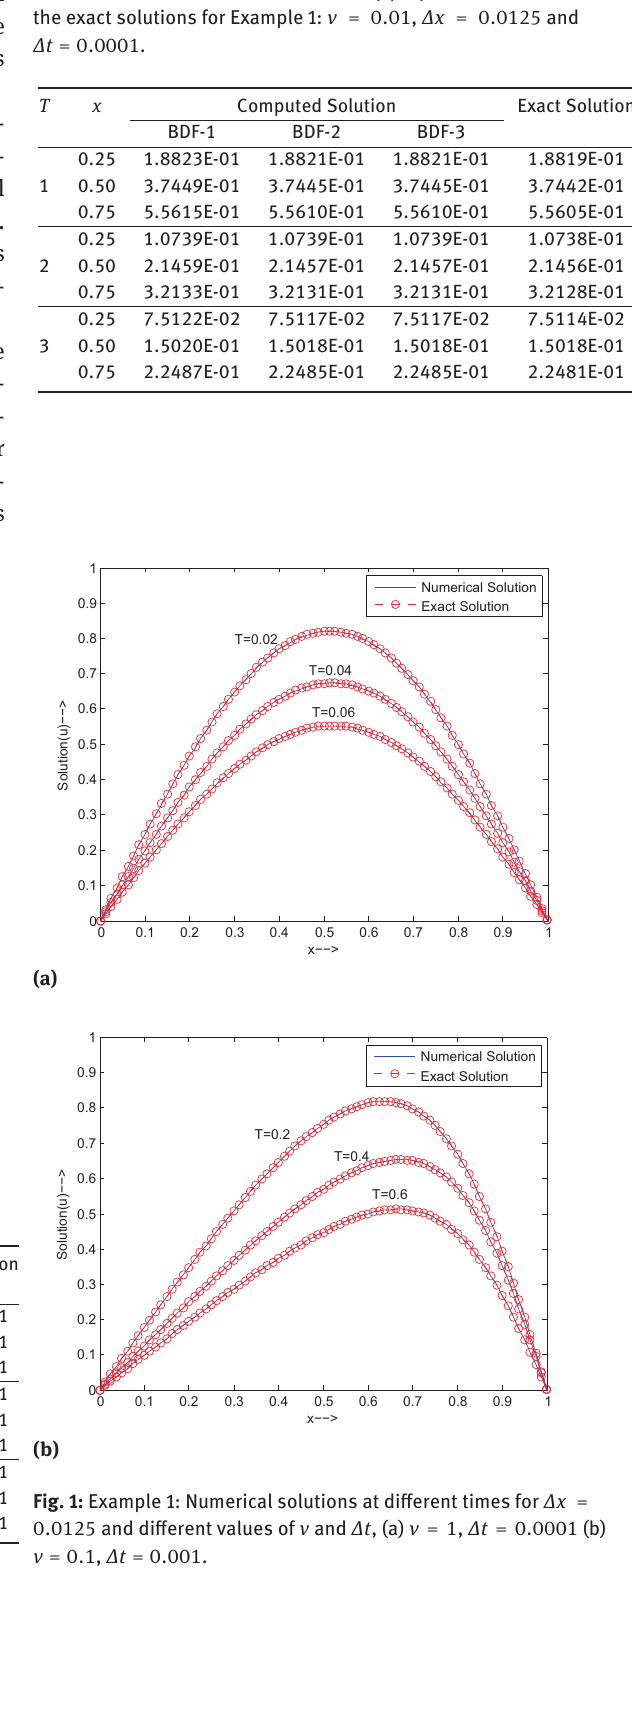
Table 3: Numerical solutions obtained by proposed schemes and the exact solutions for Example 1: ν = 0.01 , Δx = 0.0125 and